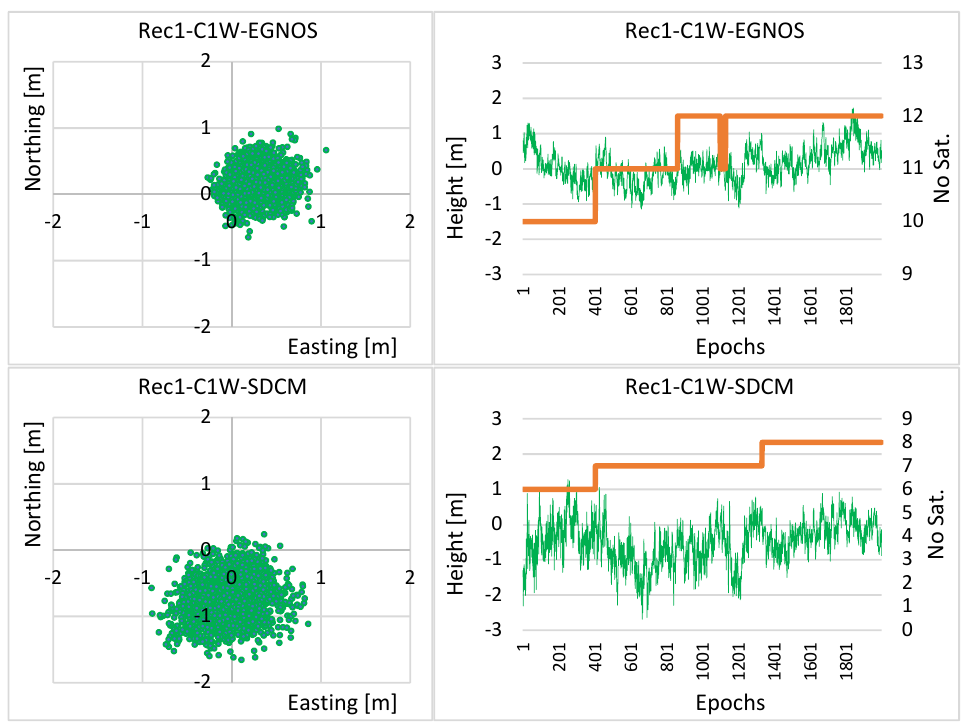
Figure 6. Real errors of horizontal and vertical coordinates of SBAS positioning based on C1C code, for the receiver Rec2 with EGNOS or SDCM corrections (Step II, see Figure 1).